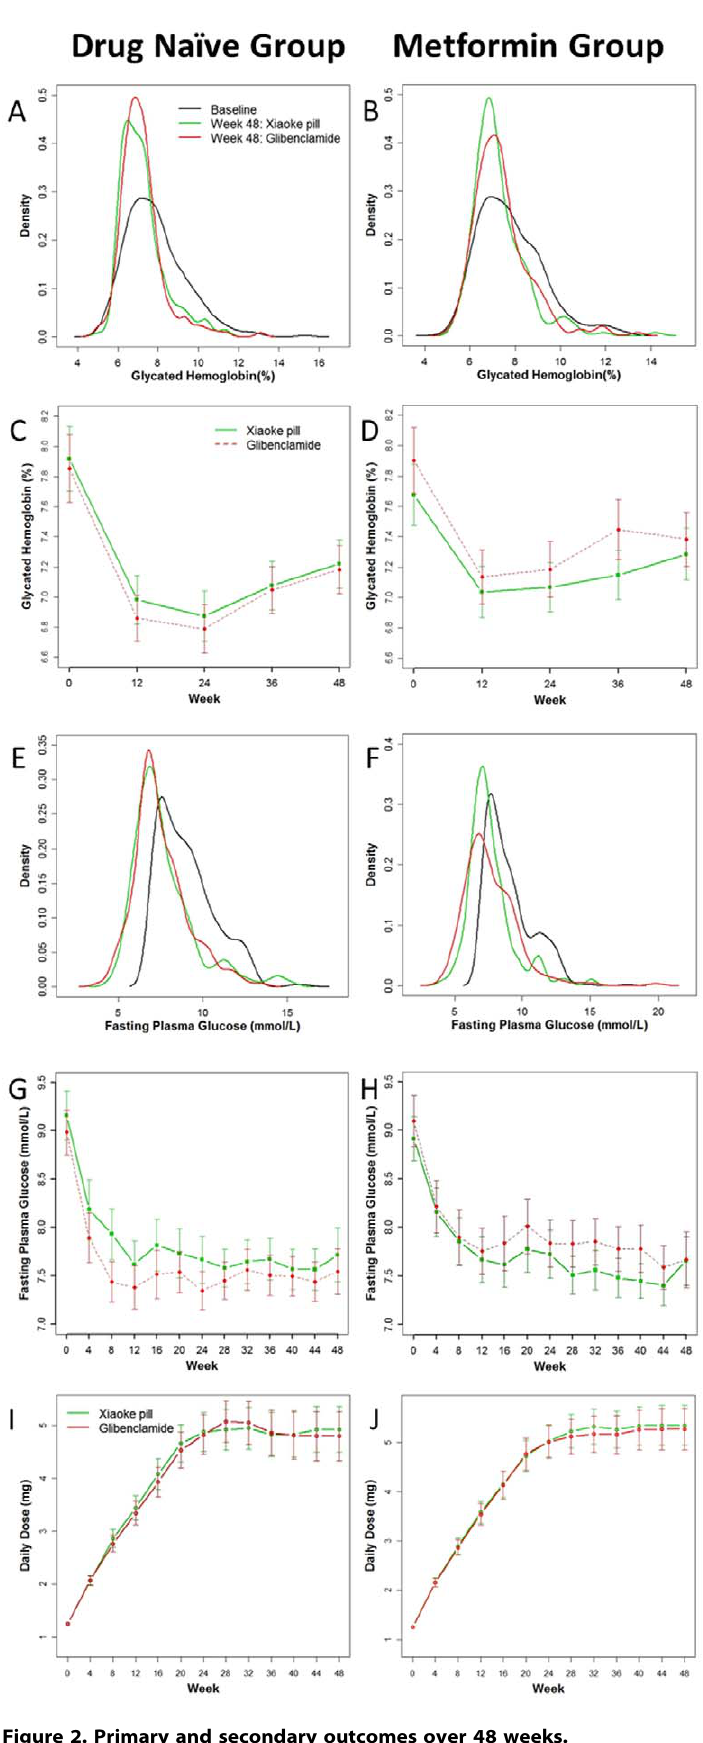
Figure 2. Primary and secondary outcomes over 48 weeks. doi:10.1371/journal.pone.0056703.g002 PLOS ONE |